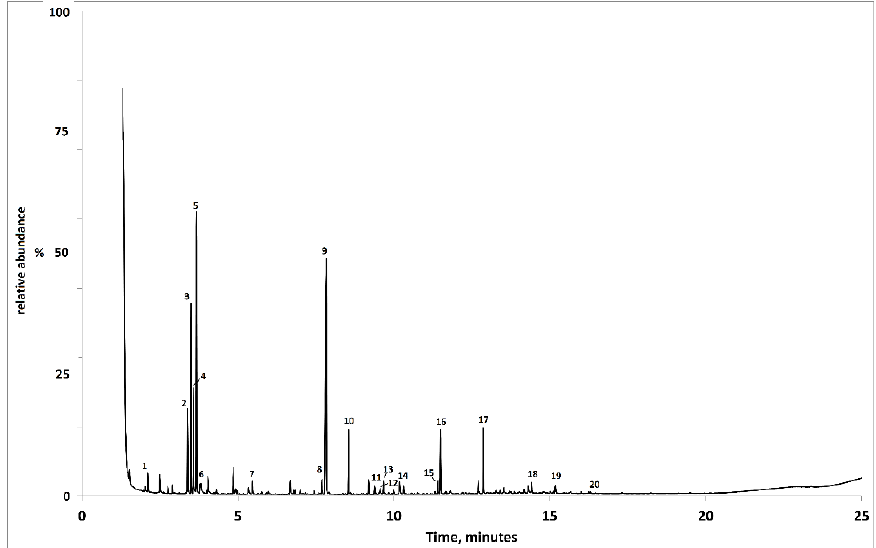
Figure 6. THM-Py-GC/MS analysis of paint sample C5a. The labelled compounds are presented in Table 3.